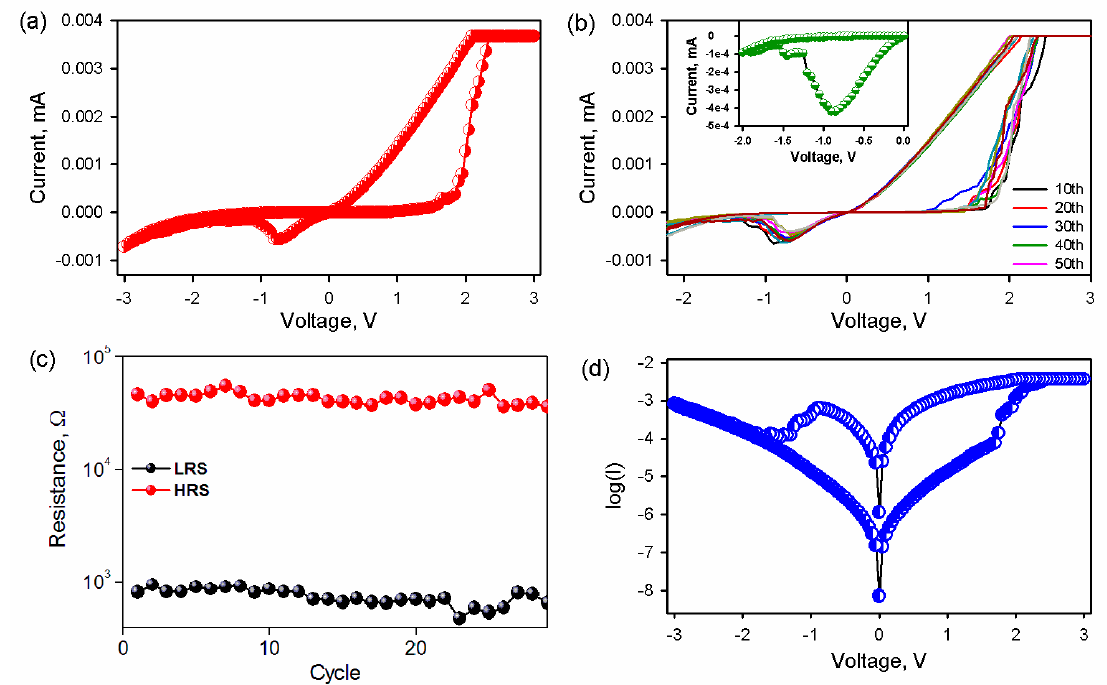
Figure 3. ( a ) Current–voltage (I-V) curve of Ag/CuO/SiO 2 /p-Si resistive switching and ( b ) multiple resistive switching up to 50 cycles depicting reproducibility. The inset shows the formation of negative differential resistance (NDR), ( c ) endurance performance of Ag/CuO/SiO 2 /p-Si, and ( d ) semi-log current–voltage characteristics of a multilayer Ag/CuO/SiO 2 /p-Si showing NDR and on-off conductance of 1 × 10 3 in the positive region. The voltage was swept from − 3 V to 3 V. The V set and V reset are 1.5 V and − 0.65 V.